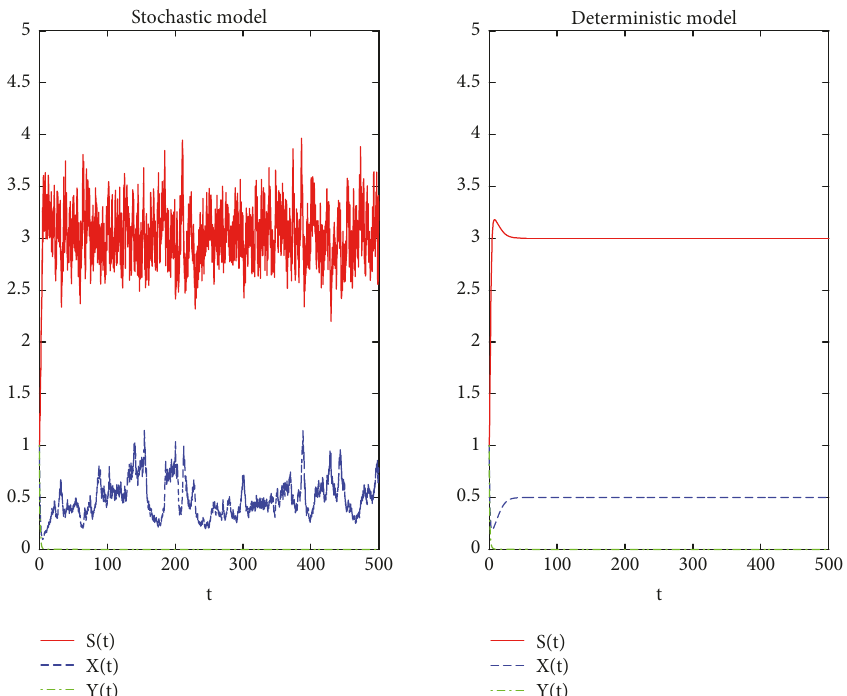
Figure 1: Numerical simulation of the solution of system (2) and its corresponding deterministic system (1) with 𝜎 1 = 0.1, 𝜎 2 = 0.1, 𝜎 3 = 0.1 , with initial value 𝑆(0) = 1, 𝑋(0) = 1, 𝑌(0) = 1 .